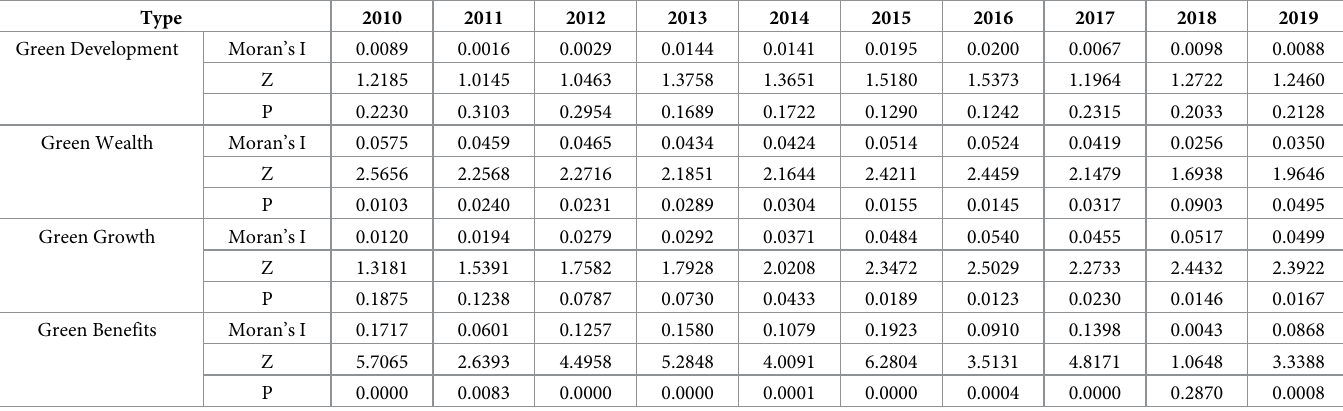
Table 3. The overall autocorrelation of China’s green-development level and its composition index from 2010 to 2019.